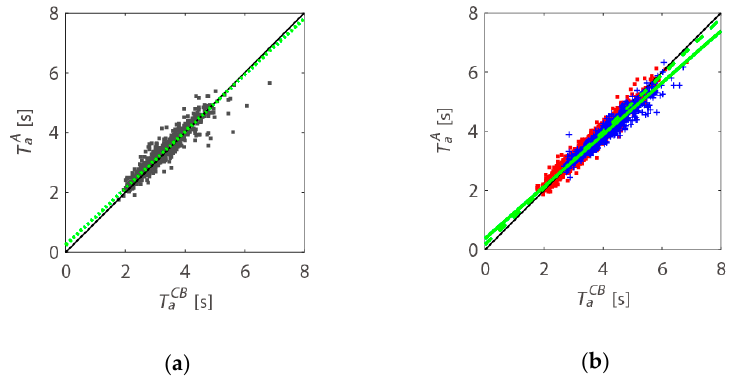
Figure 8. Buoy T CB a and altimeter T A a data when the wind speed is lower ( a ) or higher ( b ) than 5 m·s − 1 . In the right-hand panel, the blue (red) plots indicate data for which the wind speed is higher (lower) than 10 m·s − 1 . The regression lines estimated by the ODR method are plotted by the dashed (0–5 m · s − 1 ), broken (5–10 m · s − 1 ), and solid (>10 m · s − 1 ) green lines. Table 2. Correlation coefficient (CC), bias, slope of the regression line, and root mean square difference (RMSD) around the regression line for (cid:1846) (cid:3028)(cid:3002) and (cid:1846) (cid:3028)(cid:3004)(cid:3003) for various ranges of wind speed. All CC are significant at the 99.9% confidence level.